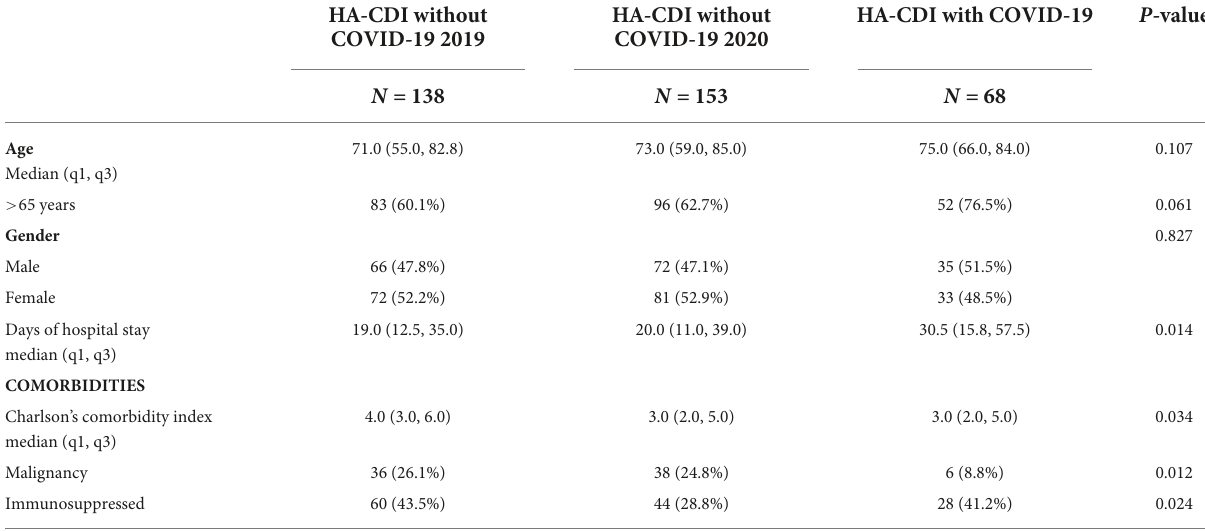
TABLE 2 Characteristics and clinical data of patients with hospital acquired Clostridioides difficile infection with and without coronavirus